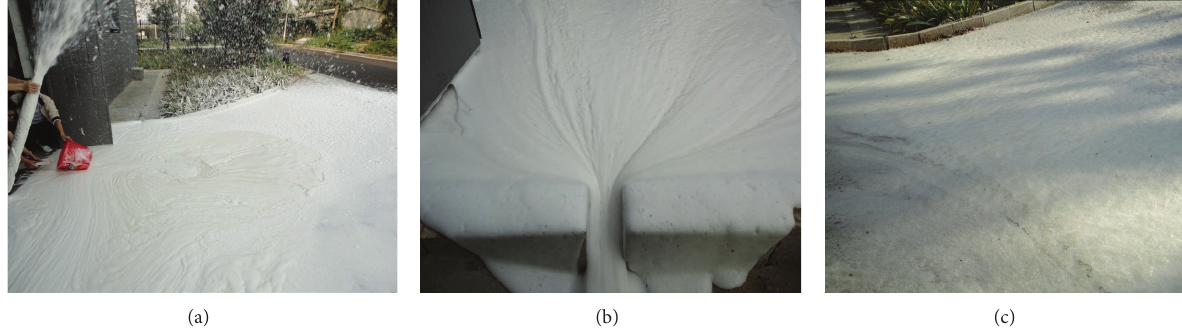
Figure 7: The foamed gel prepared in lab. (a) Foaming, (b) fluidity, and (c) film forming